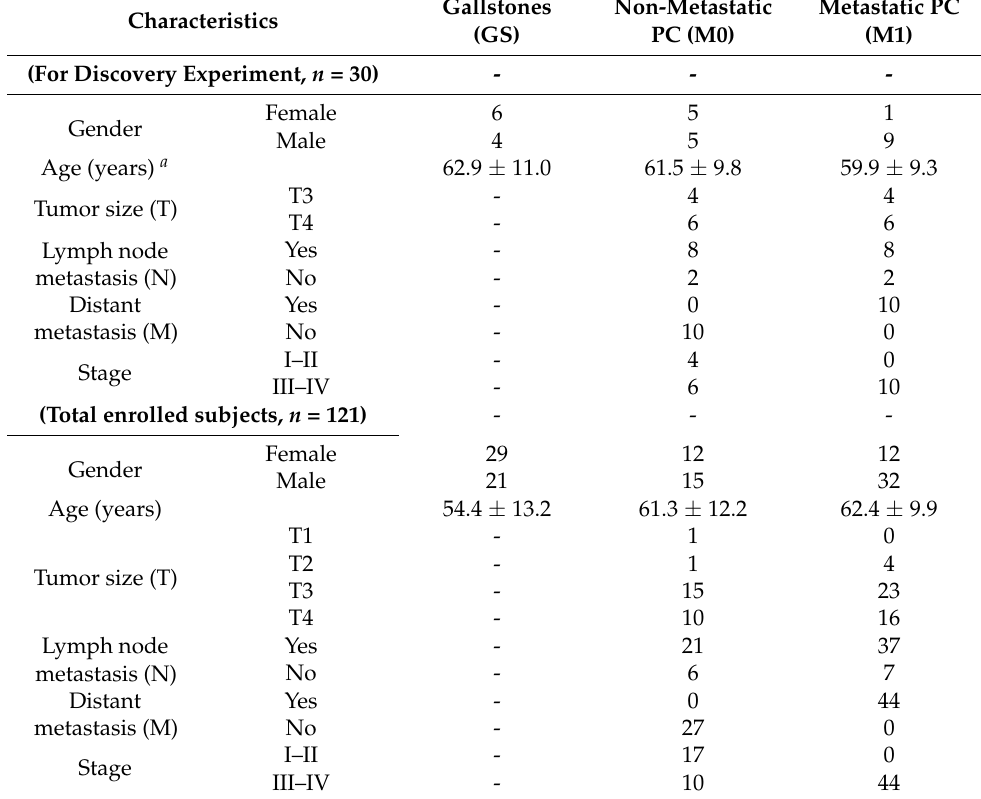
Table 1. Clinicopathological characteristics of the enrolled subjects used in this study.